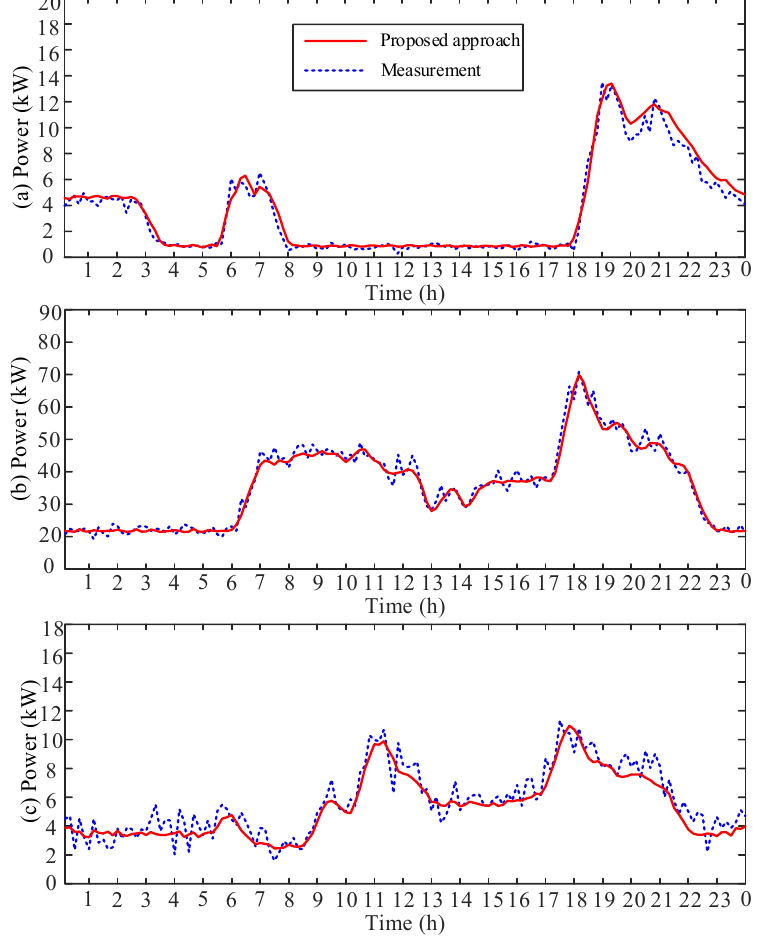
Figure 5. Forecasting results for three categories of household: ( a ) worker family; ( b ) senior + worker family; ( c ) senior